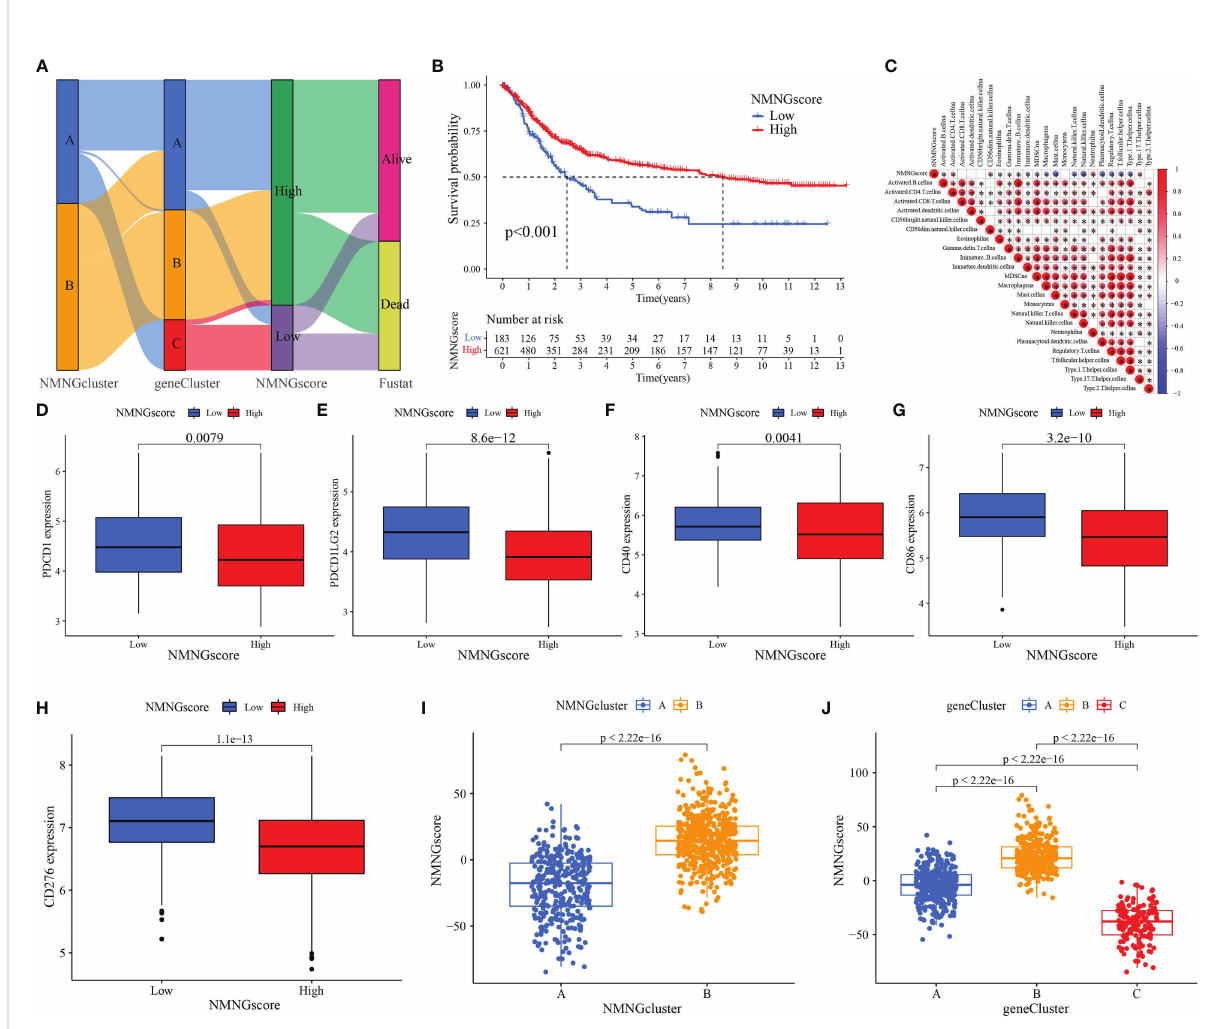
FIGURE 7 Construction of NMNG signature and exploration of its clinical signi fi cance. (A) Alluvial diagram showing the changes in NMNGclusters, gene clusters, NMNGscore, and survival status. (B) Survival outcomes of patients by NMNGscore. (C) Correlation between NMNGscore and immune cells. Blue represents negative correlations and red represents positive correlations. (D-H) Expression of immune checkpoints (PDCD1, PDCD1LG2, CD40, CD86, and CD276) among low and high NMNG score groups. (I) Variation analysis of NMNGscore between NMNGclusters. (J) Variation analysis of NMNGscore between gene clusters.